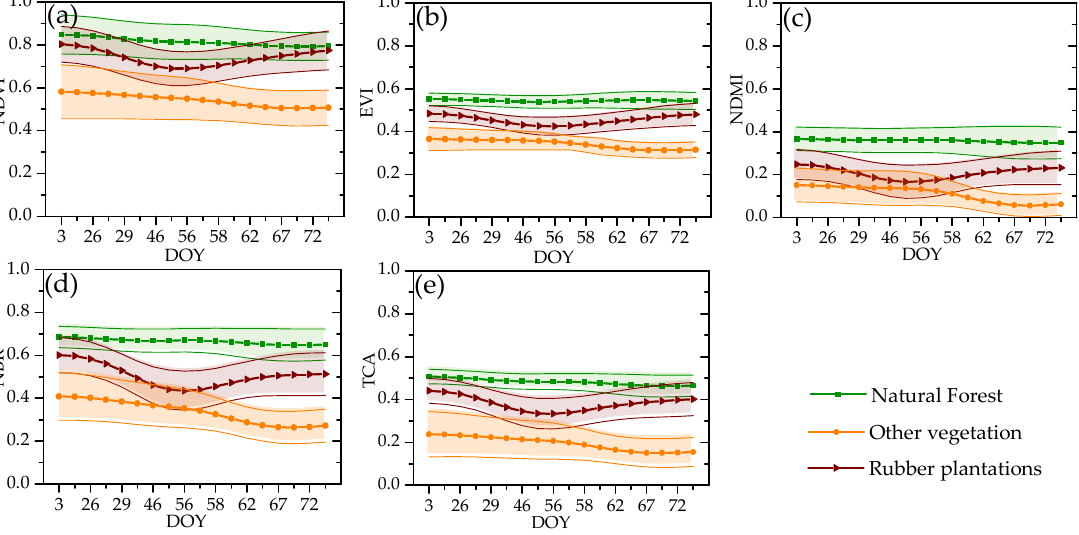
Figure 9. The time series of EVI data: ( a ) time series curves of the main vegetation coverage in 2000; ( b ) time series curves of the main vegetation coverage in 2005; ( c ) time series curves of the main vegetation coverage in 2010; ( d ) time series curves of the main vegetation coverage in 2015. According to the analysis results in the previous section, we used the EVI to analyze the growth characteristics of different vegetation types. Limited by the Landsat acquisition time, the beginning and ending times were different for each of the 4 years. However, the time series vegetation index curves for each of the four years had the same distinguishable features and trends after filtering, as shown by the EVI curves in Figure 9. The features could be summarized as follows. ⅰ ) The EVI values